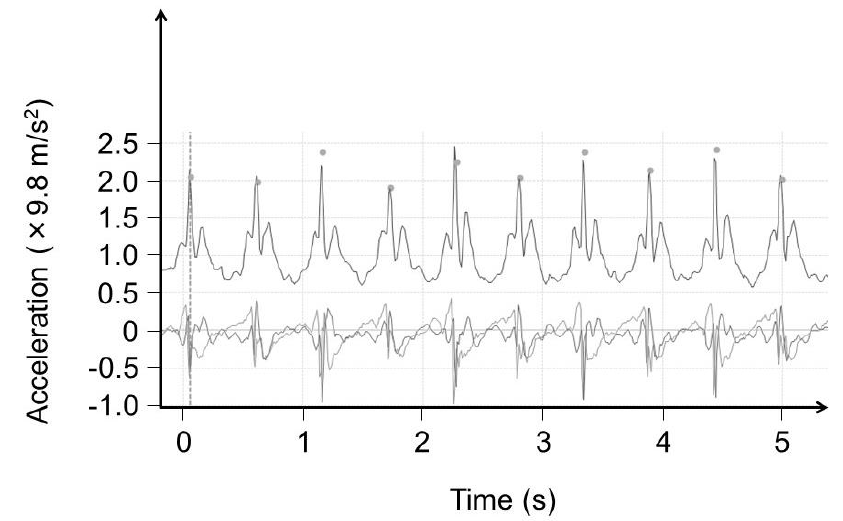
Figure 2. Wave dataset obtained using a tri-axial accelerometer during walking.